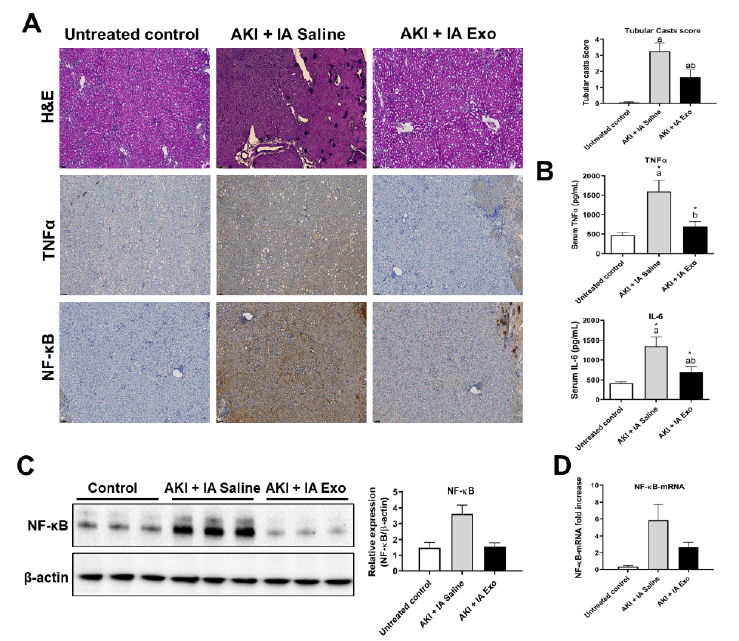
Figure 3. Inflammatory cytokines. ( A ) Hematoxylin and eosin (H&E) staining and immunohistochemistry (IHC) of kidney tissue, stained for TNF- α and NF- κ B, and quantification of tubular casts. ( B ) Serum concentrations of TNF- α and IL-6, as measured by serum ELISA. ( C ) Western blot and quantification of NF- κ B and β -actin from kidney lysate. ( D ) mRNA expression of NF- κ B, as measured by qRT-PCR. Measurements were taken at day 12. Each group has n = 5 mice for TNF- α and IL-6 measurements and n = 3 mice for NF- κ B measurements. Significant di ff erence a p < 0.05: relative to untreated control group; b p < 0.05: relative to AKI + IA saline